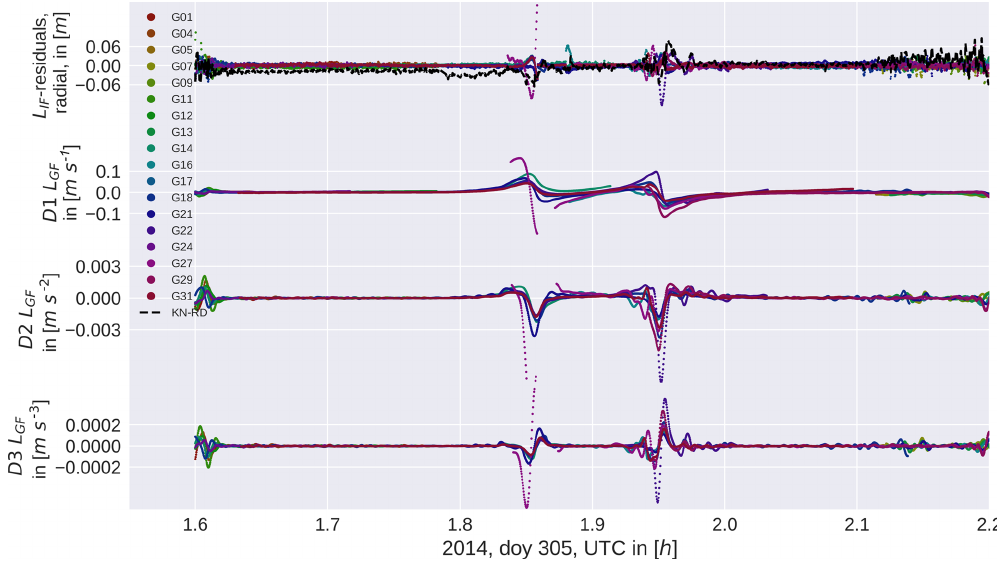
Figure 2. Phase residuals in reduced-dynamic positioning (top) and time derivatives of the geometry-free linear combination during one equatorial pass.